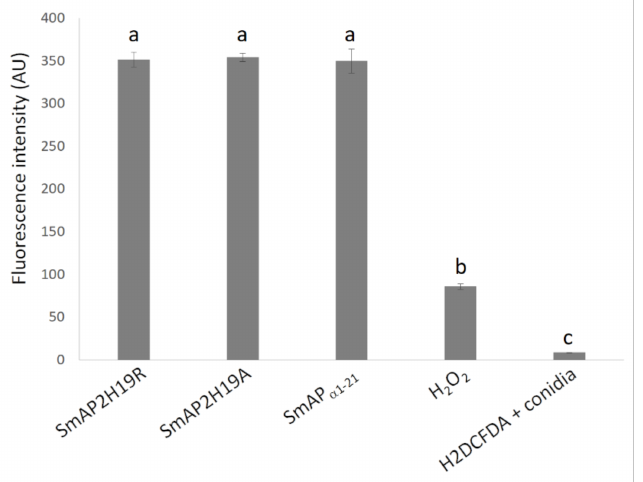
Figure 6. Quantitative fluorescence of conidia treated with peptides SmAP α 1-21 , SmAP2H19R, and SmAP2H19A at micromolar concentrations and H 2 DCFDA (10 µ M), H 2 O 2 (88 mM), or water (H 2 DCFDA + conidia) for 90 min. Fluorescence intensity is expressed in arbitrary units. Bars are mean values ± SD from 3 replicates and 2 independent assays (n = 6). Treatments with same letter do not significantly differ ( p >